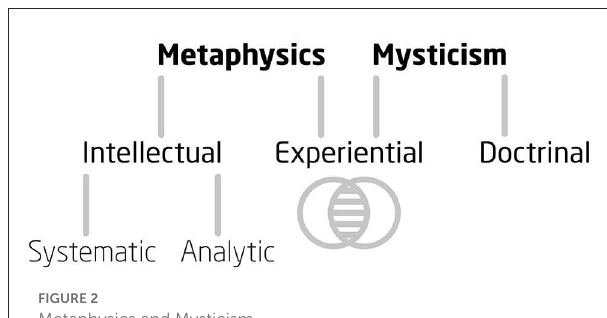
FIGURE2 Metaphysics and